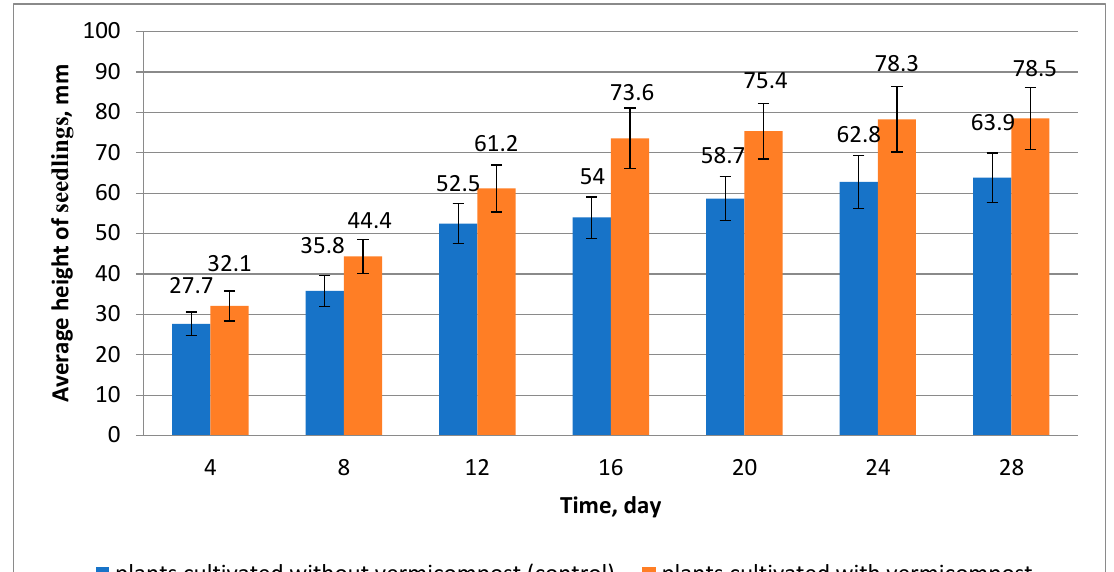
Figure 5. Vermicompost influence on S. tau-saghyz seedling height. The average values of the seedling height and the number of leaves generated during the experiment were compared to provide a more reliable picture of the impact of the vermicompost. Figure 5 depicts the results. The average values of the plant height and leaf quantity were about 1.5 times greater than those in the control. The average plant heights in the experiment and the control were 61.4 ± 3.20 and 40.1 ± 2.40 mm, respectively, whereas the leaf quantities were 9.00 ± 0.50 and 6.13 ± 0.40, respectively (Figure 6).